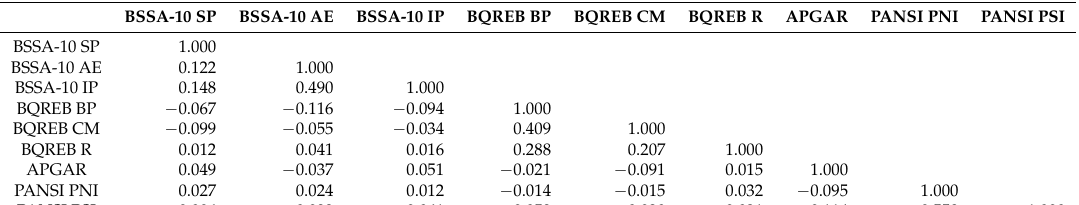
Table 3. Correlation matrix for different scales/sub-scales of the PANSI, BSSA-10, BQREM, and the APGAR instruments.